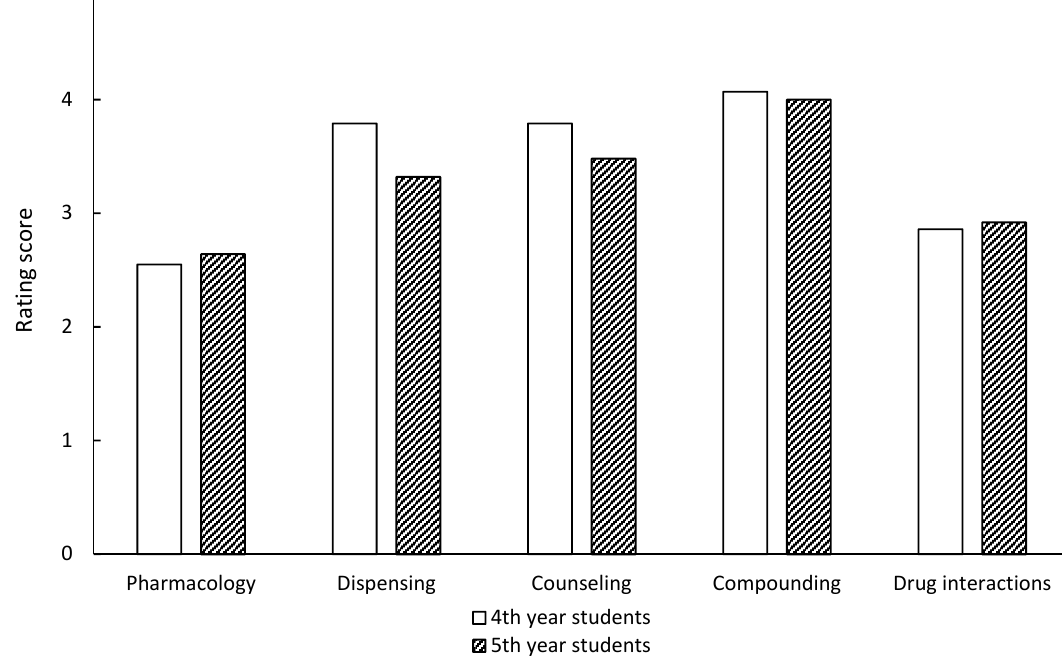
Figure 1. Average rating response by veterinary students about the degree to which they had learnt about aspects of patient treatment (with 1 being a large part of the course and 5 being never). Table 1. Areas identified by veterinary students at Massey University in New Zealand where they would like to learn more